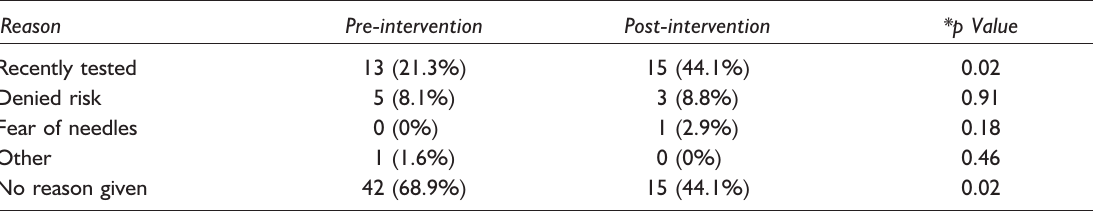
Table 4 Reason for decline of HIV test: number and percentage of refusals in each group Reason Pre-intervention Post-intervention *p Value Recently